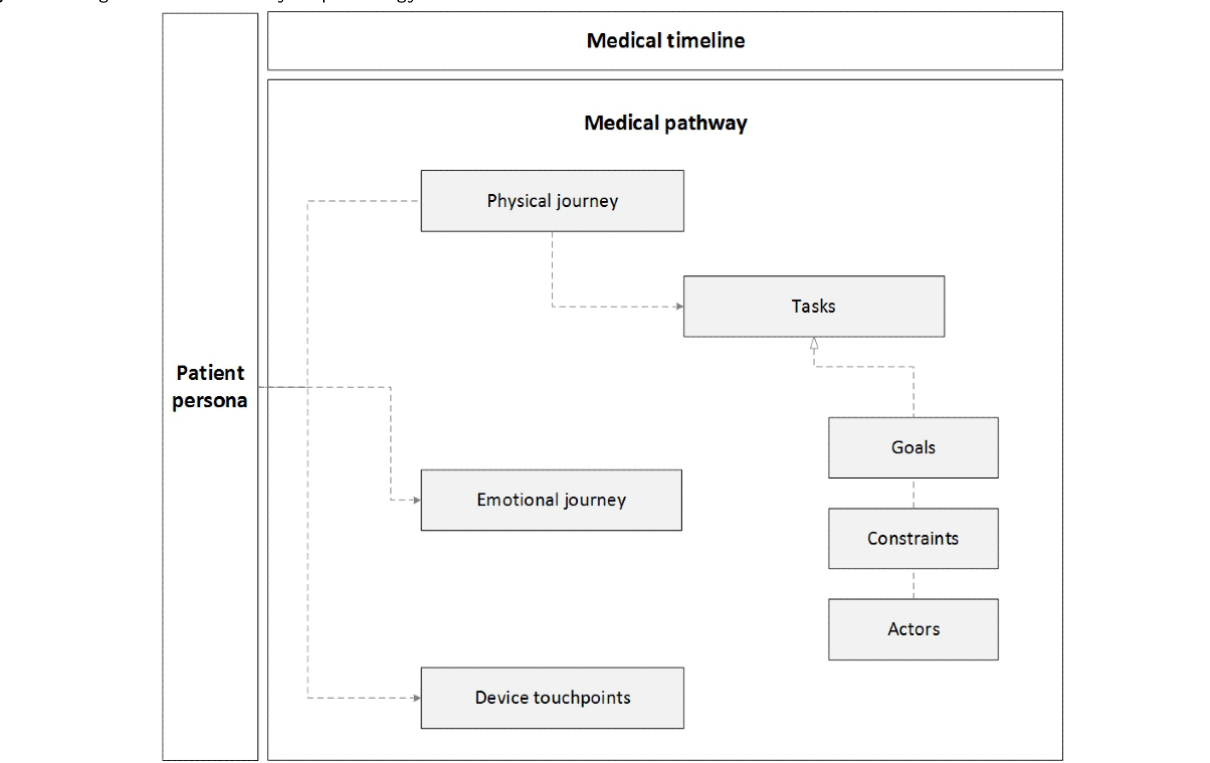
Figure 1. Integrated Patient Journey Map